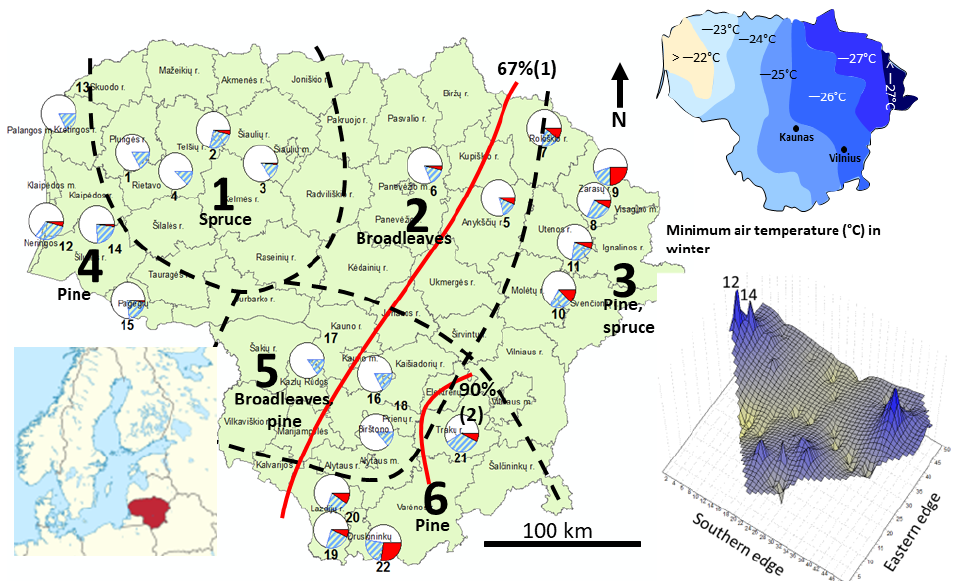
Figure 1. Scots pine population genetic structure in Lithuanian based on nuclear microsatellite (nSSR) markers. The pie charts indicate the location of the Scots pine populations studied as well as the population proportions of the genetic clusters identified by the STRUCTURE Bayesian clustering of the populations based on the nSSR data. The BARRIER-based modeling with Nei’s [85] among-population genetic distances of the two major boundaries (with highest number of bootstraps) for a significant change in the nSSR allele frequencies are shown as solid red lines, with the % out of the 1000 bootstraps returning these barriers shown at the barriers. The dashed lines and large numbers 1 to 6 indicate the six forest natural regions (FNR). The dominant forest tree species is shown at the FNR ids. (pine = Scots pine, spruce = Norway spruce). The lower-right map shows genetic structure as revealed by landscape-shape interpolation of genetic distances among populations (midpoints of edges by Delaunay triangulation, AiS software). The upper-right map shows the main climatic gradient for frost hardiness (averages of the daily indexes over the period of 1981–2011, Galvonait ė et al. [94]). More details on climate in Lithuania in Figure S1 and Table S1.